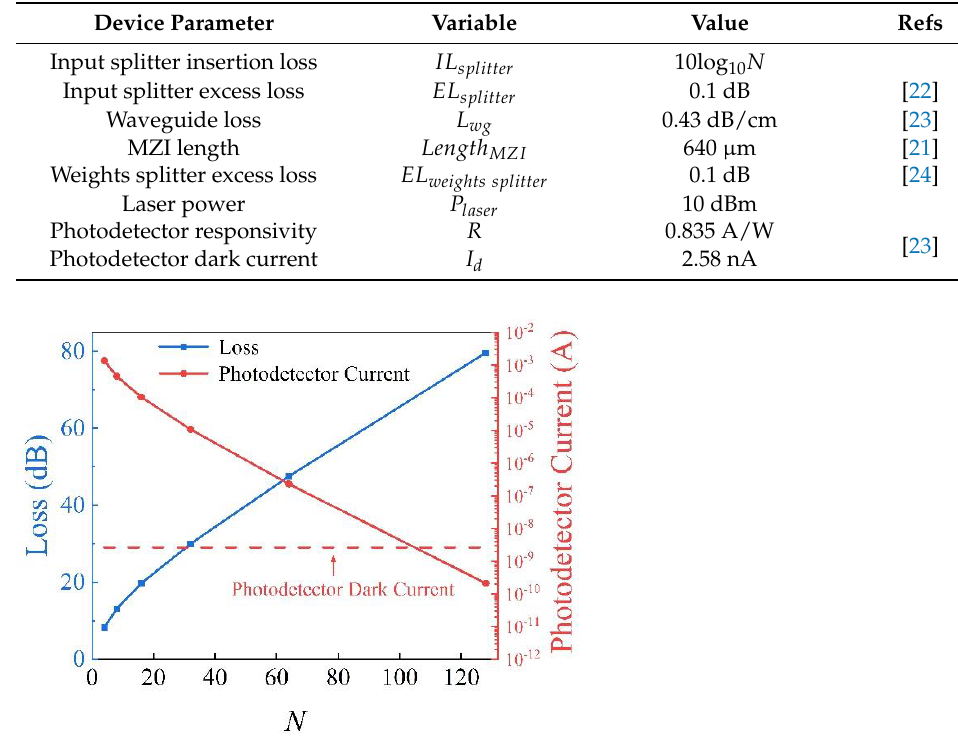
Figure 7. Loss (blue) and detector current (red) of the single-core N × N PCNN chip.